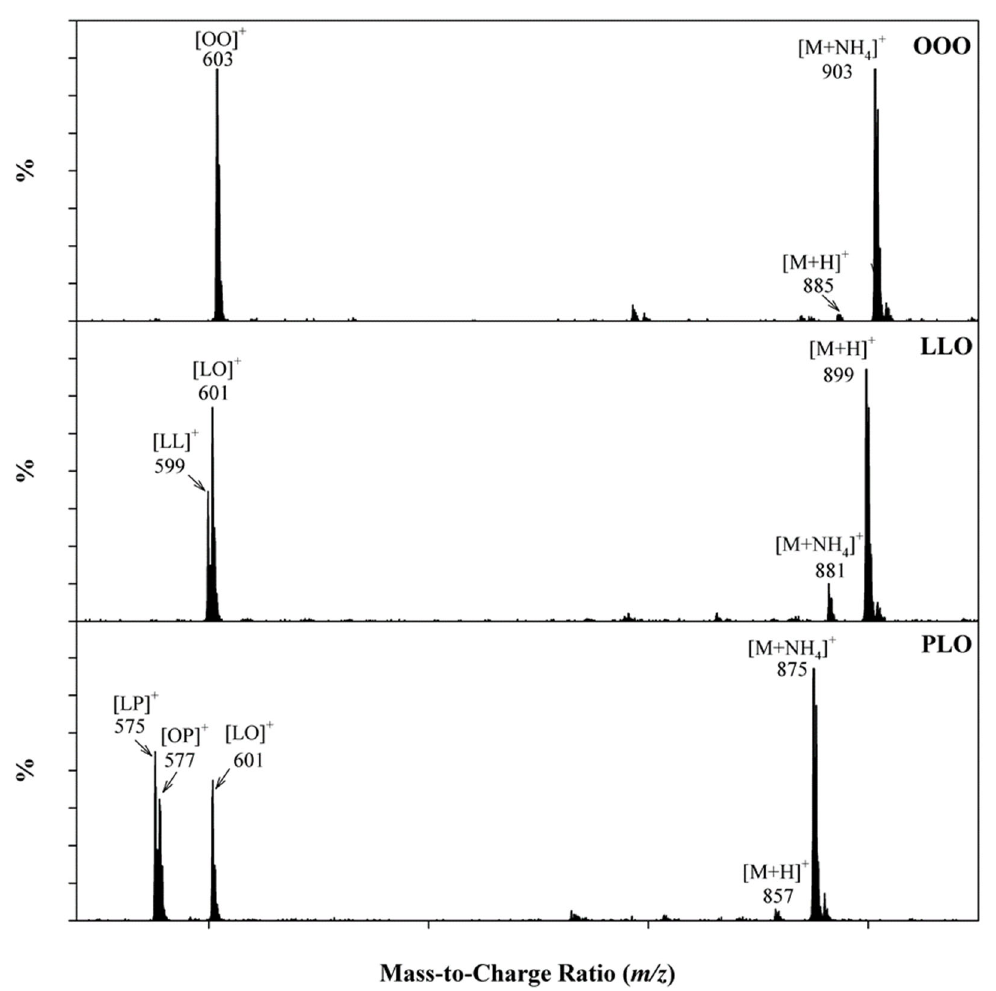
Figure 6. Representative ESI(+) MS spectra to demonstrate the identification of triglycerides with different acyls on the glycerol backbone.